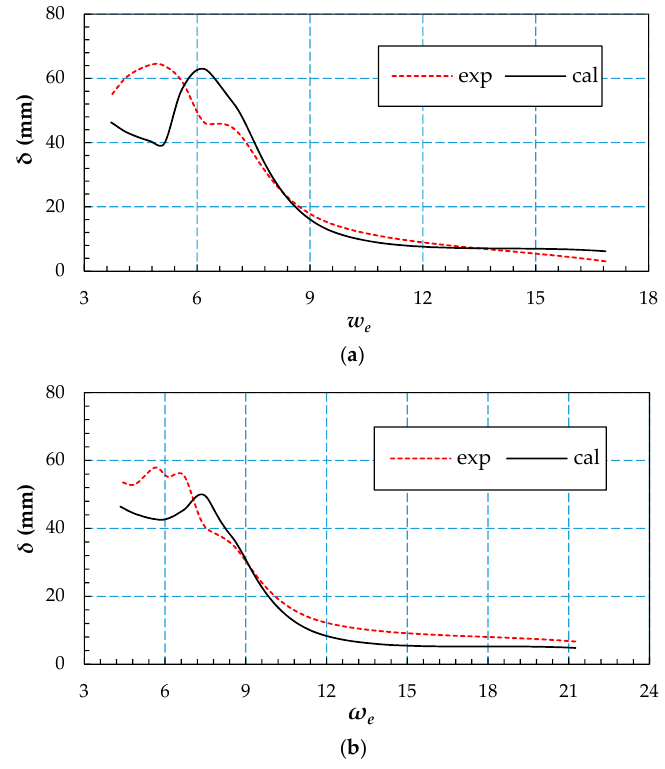
Figure 25. The contrast curves of heave response of ( a ) F n = 0.71 and ( b ) F n = 0.99.